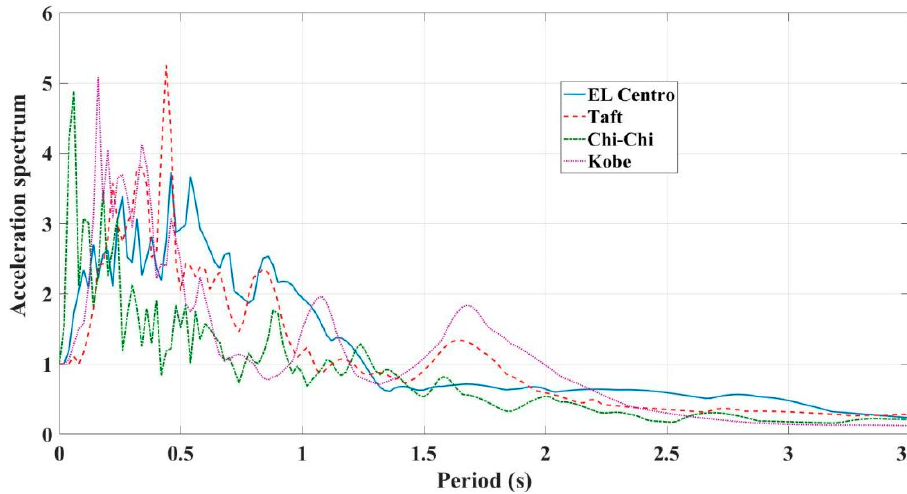
Figure 16. Normalized acceleration spectra of earthquake records.